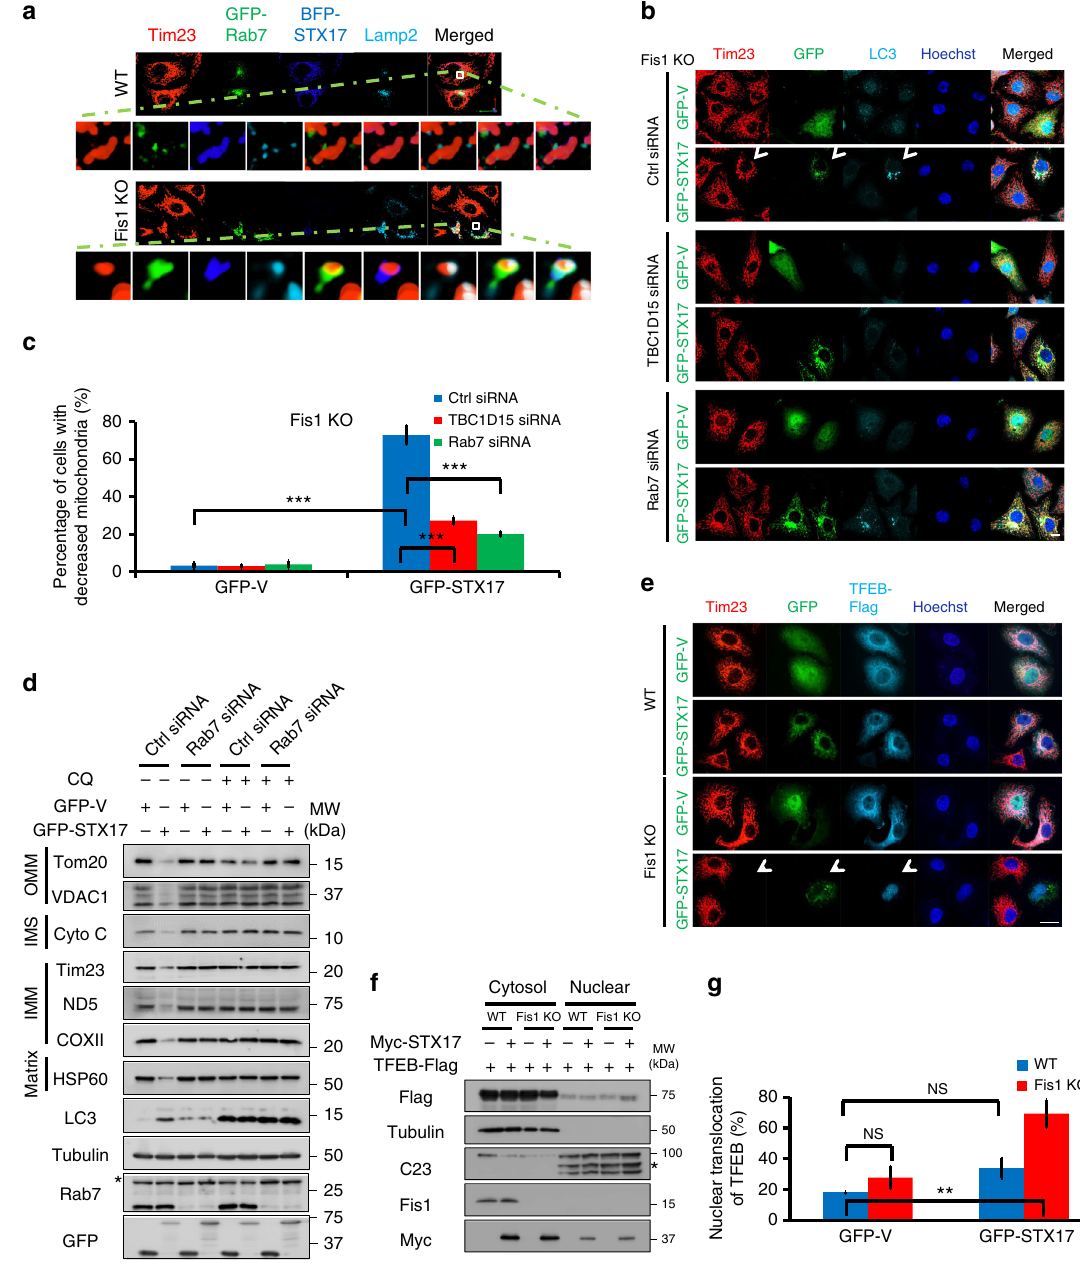
Fig. 7 Transcription factor EB (TFEB) and Rab7 are involved in syntaxin 17 (STX17)-initiated mitophagy upon mitochondrial fi ssion 1 protein (Fis1) loss. a Wild-type ( WT ) or Fis1 knockout ( KO ) HeLa cells were co-transfected with plasmids encoding green fl uorescent protein (GFP)-Rab7 (green) and blue fl uorescent protein (BFP)-STX17 (blue) for 24 h. Cells were fi xed and immunostained for Tim23 (red) and Lamp2 (cyan). Cells were visualized as three- dimensional reconstruction images. b Fis1 KO HeLa cells were transfected with control-, TBC1D15 -, or Rab7 -small interfering RNA (siRNA) for 24 h. Cells were transiently transfected with GFP-tagged vector or STX17 (green) for further 24 h. Mitochondria and autophagosome were highlighted by Tim23 (red) and LC3 (cyan). Hoechst, blue. Scale bar, 10 µ m. Arrowhead indicates mitophagic cell. c Quanti fi cation of mitophagic cells in b . *** P < 0.001 (two-tailed unpaired Student ’ s t test from three independent experiments, n = 150). d Fis1 KO cells were transfected with control- or Rab7 -siRNA for 24 h. Cells were then again transfected with respective siRNA, plus GFP-tagged vector or STX17 for further 6 h. Hereafter, cells were cultured with or without chloroquine (CQ) for another 66 h. Cells were harvested and lysed, followed by sodium dodecyl sulfate-polyacrylamide gel electrophoresis (SDS-PAGE) gel separation and immunoblotting against overall mitochondrial proteins. e WT or Fis1 KO HeLa cells were co-transfected with GFP-tagged vector or STX17 (green) and TFEB-Flag (cyan) for 24 h. Cells were fi xed and immunostained against Tom20 (red) and Flag (cyan). Hoechst, blue. Scale bar, 10 µ m. Arrowhead indicates mitophagic cell. f WT or Fis1 KO HeLa cells treated as in e were fractioned, lysed, and immunoblotted. Asterisk indicates non-speci fi c bands. g Quanti fi cation of f . TFEB-Flag expression level was normalized to Tubulin (cytosol) or C23 (nuclear). Nuclear TFEB-Flag was indicated as the percentage of total TFEB-Flag. ** P < 0.01, NS, not signi fi cant (two-tailed unpaired Student ’ s t test, n = 3). Error bars represent SD ( c and g